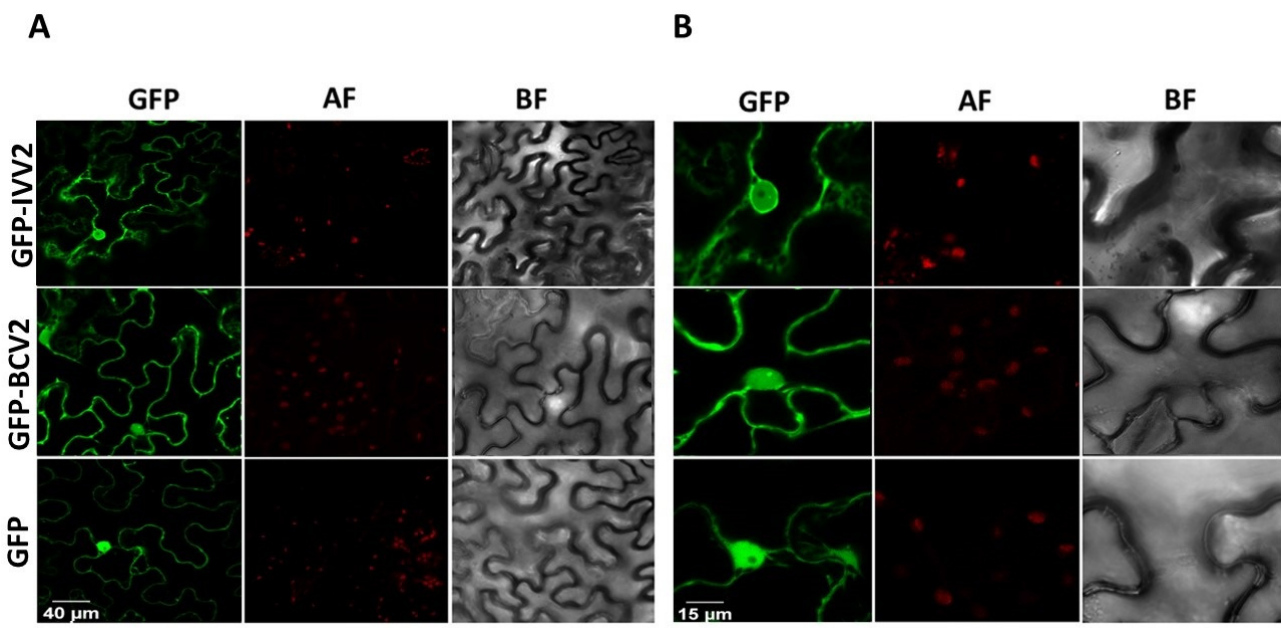
Figure 5. Subcellular localization of V2 from beet curly top Iran virus fused to GFP in epidermal cells of wild type Nicotiana benthamiana . ( A ) Leaves were agroinfiltrated with a construct expressing the GFP (GFP), GFP-V2 fusion protein from beet curly top Iran virus (GFP-IVV2), or the GFP-V2 fusion protein from beet curly top virus (GFP-BCV2). Samples were observed under the confocal microscope at 36 h post infection. ( B ) Close up confocal images of the observed areas. GFP fluorescence (GFP), autofluorescence (AF), and the bright field channel (BF) are